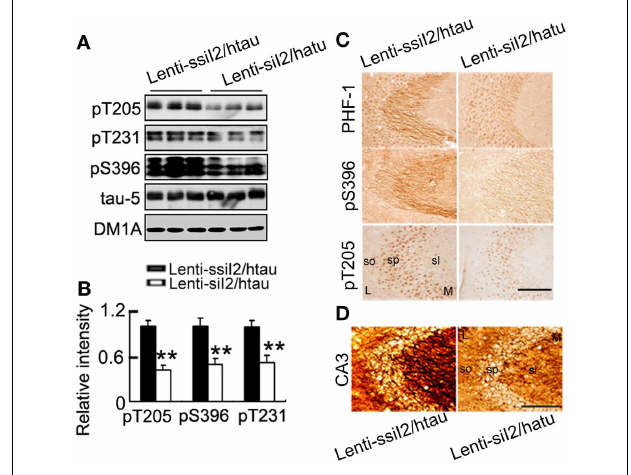
FIGURE 2 | Expression of Lenti - siI PP2A arrests tau pathology in htau 2 mice . Approximately 11-month-old htau mice received brain infusion of the Lenti - siI PP2A (Lenti-siI 2 ) or the scrambled Lenti - ssiI PP2A (Lenti-ssiI 2 ; 2 µ l 2 2 each, 2 × 10 9 TU/ml) into the hippocampal CA3 region under a stereotaxic instrument as described in the Section “Materials and Methods.” Four weeks later, the expression level of tau phosphorylation at several AD-related sites was detected byWestern blotting (A,B) and immunohistochemistry (C) .The silver staining images were represented. (D) L, lateral; M, medial; sl, stratum lucidum; so, stratum oriens; sp, stratum pyramidale.The data were presented as mean ± SD of three